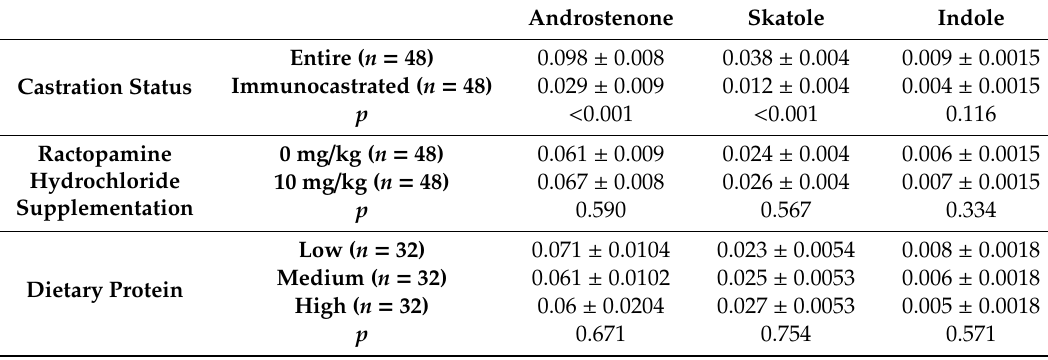
Table 5. The concentrations ( µ g / g) of androstenone, skatole and indole in the adipose tissue of immunocastrated and entire male pigs, fed varying protein diets, with or without ractopamine hydrochloride for the last 28 days of finishing. Results are reported as LS Mean ±